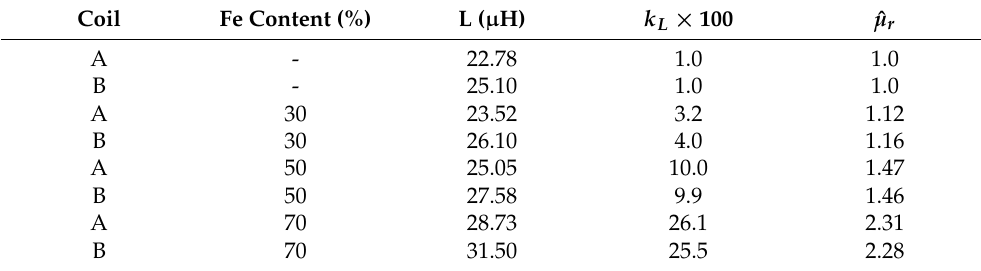
Table 3. The results of the inductance measurements for varying iron powder content with the calculated relative inductance and the estimated magnetic permeability.